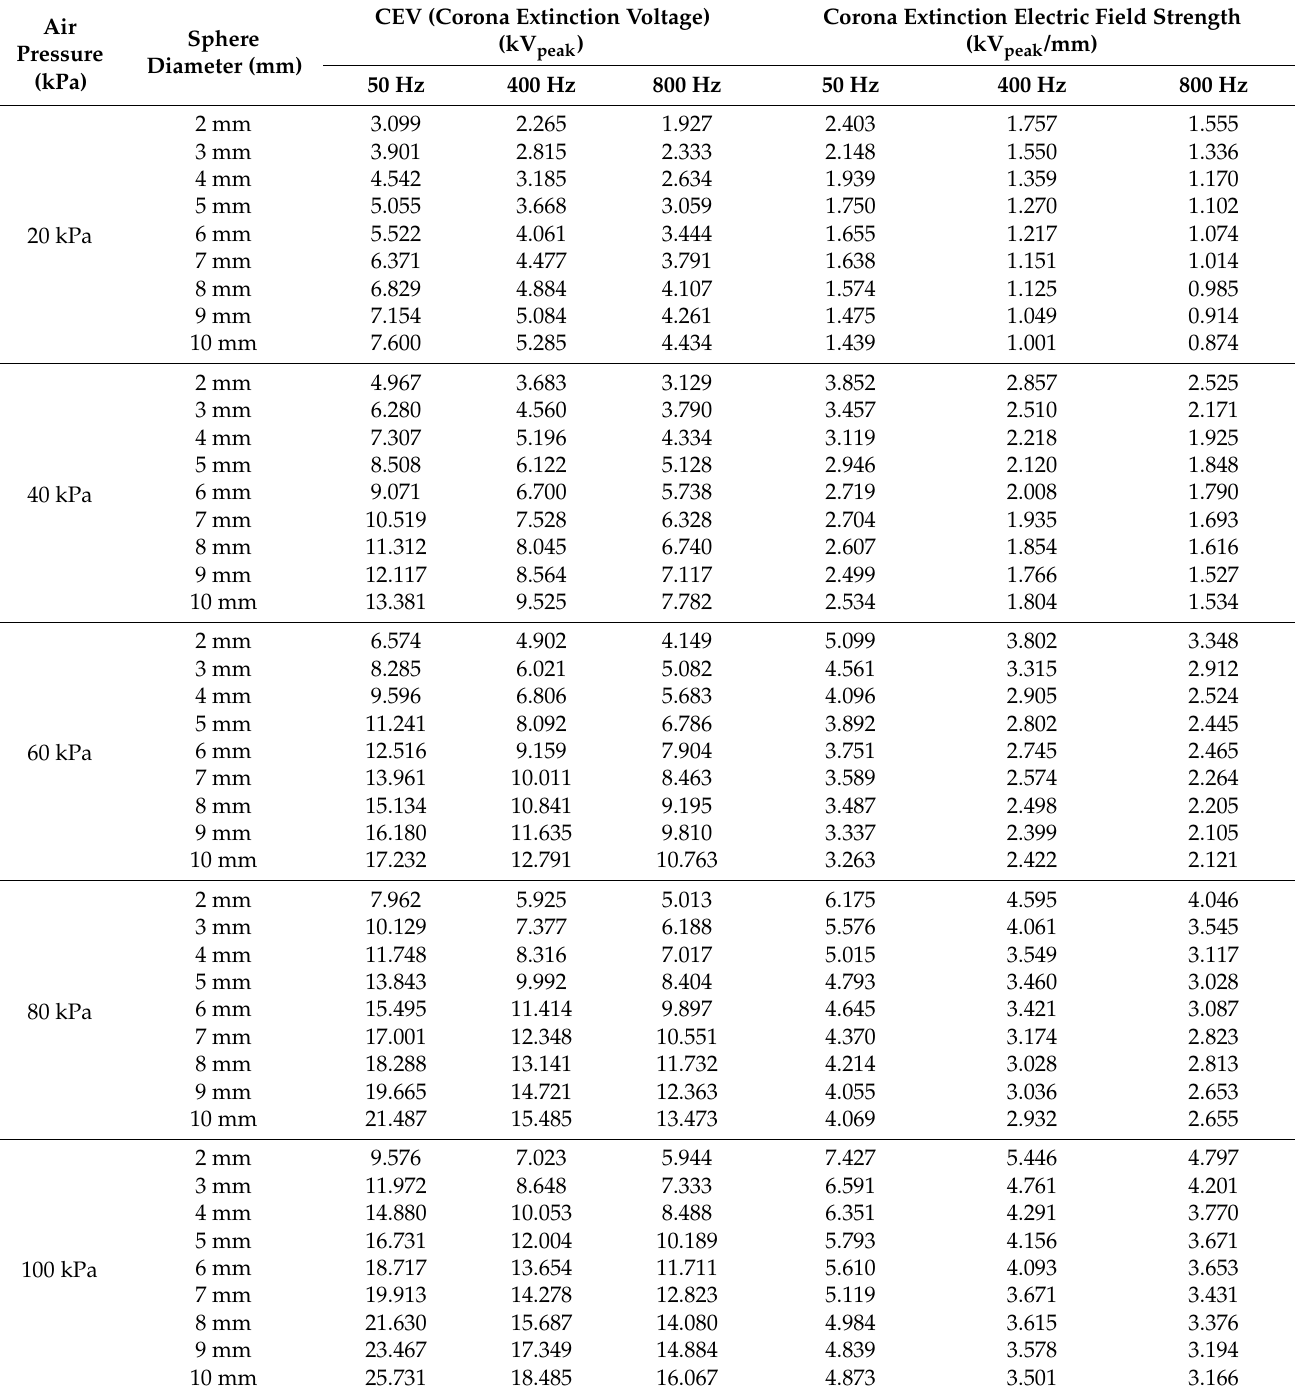
Table 1. Summary of experimental values of the measured CEV value and the corona extinction electric field strength (CEV conditions) calculated by means of FEM